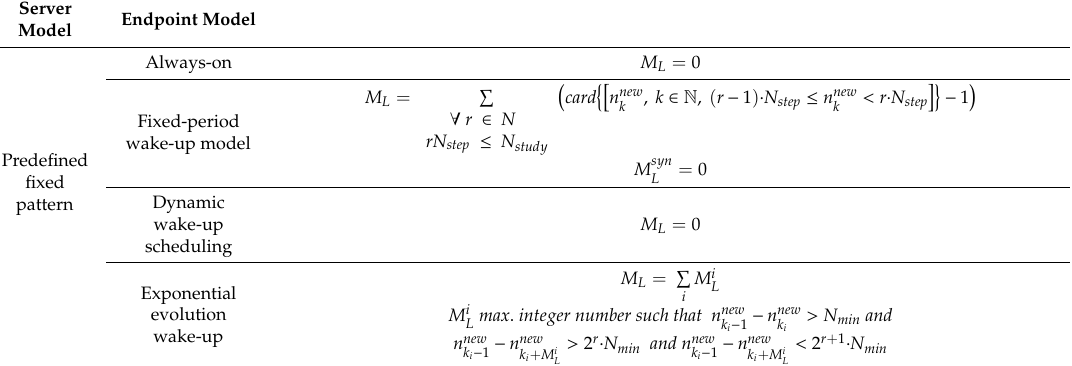
Table 2. Total number of lost blocks in the proposed scenario. Random